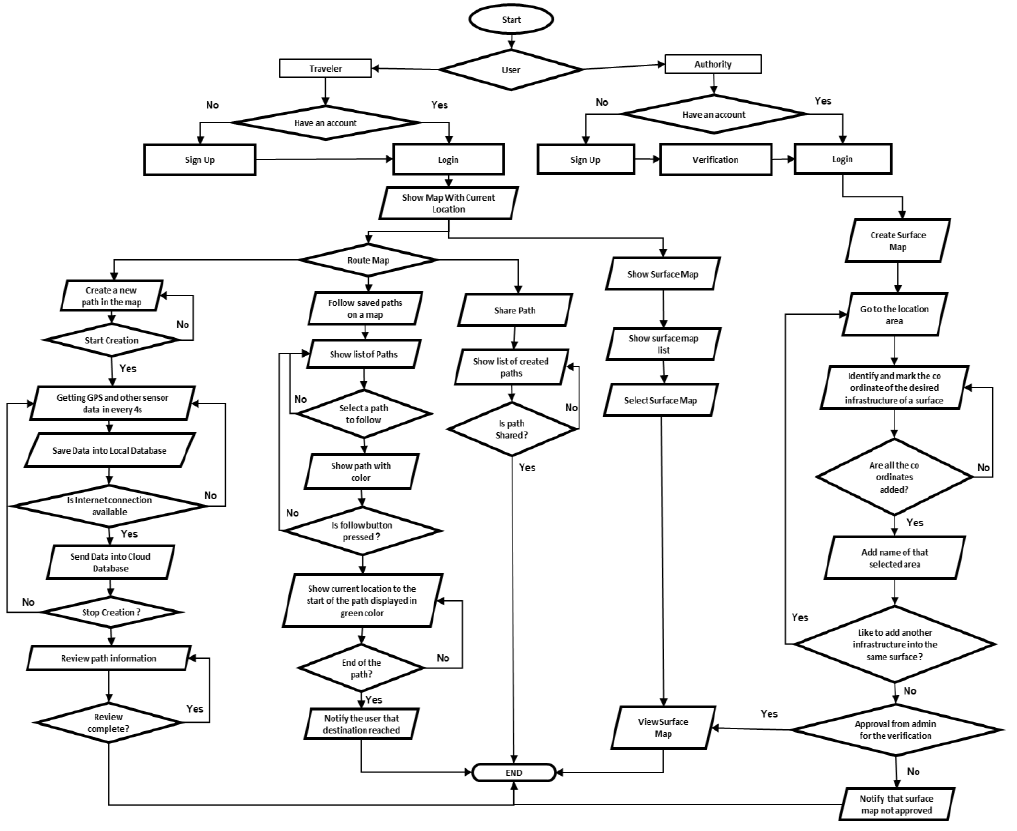
Figure 4. The detailed workflow of the proposed application.